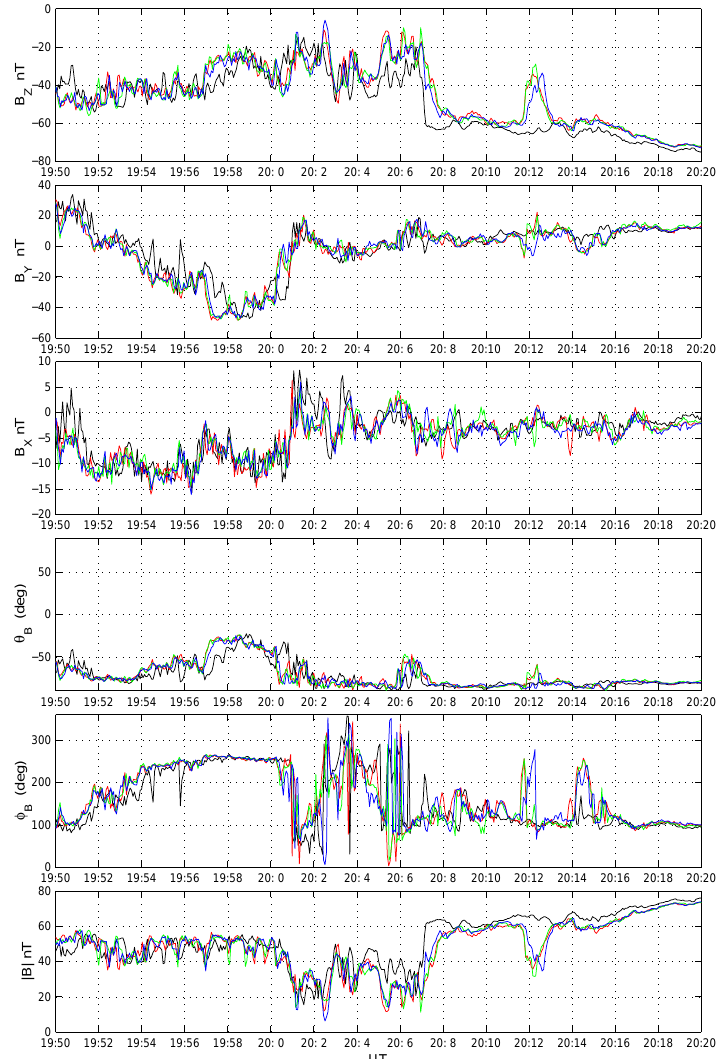
Fig. 10. The three magnetic field components, the angles θ and φ and the field magnitude between 19:50 and 20:20UT on 13 February